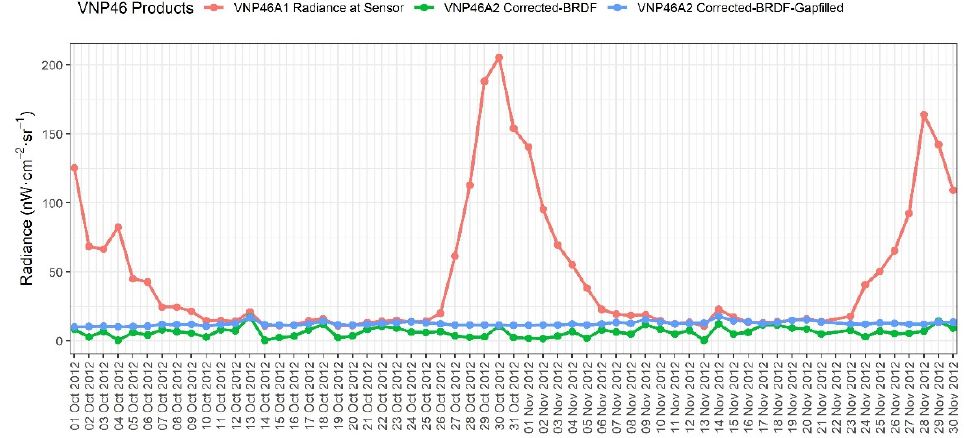
Figure 2. Daily average nighttime lights in Tile h10v04 from 1 October 2012 to 30 November 2012.